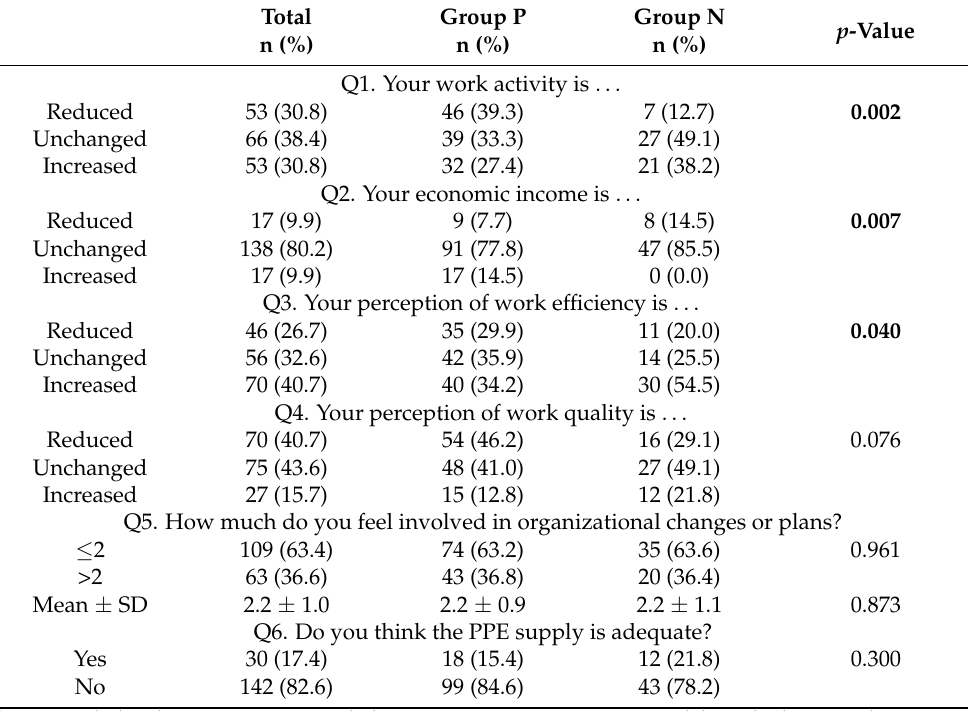
Table 2. Description of the interview results regarding work environment during COVID-19 pan- demic (n = 172).